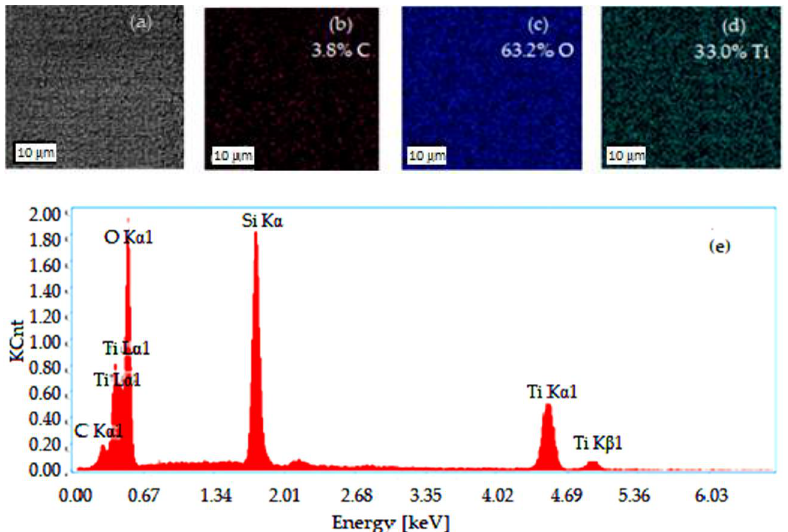
Figure 3. EDS analysis results of TiO 2 powder film ( a ); the EDS mapping of C ( b ); the EDS mapping of O ( c ); the EDS mapping of Ti, as elements of the TiO 2 film deposited on TiC disk ( d ); the EDS spectrum of the area shown in Figure 3a ( e ).